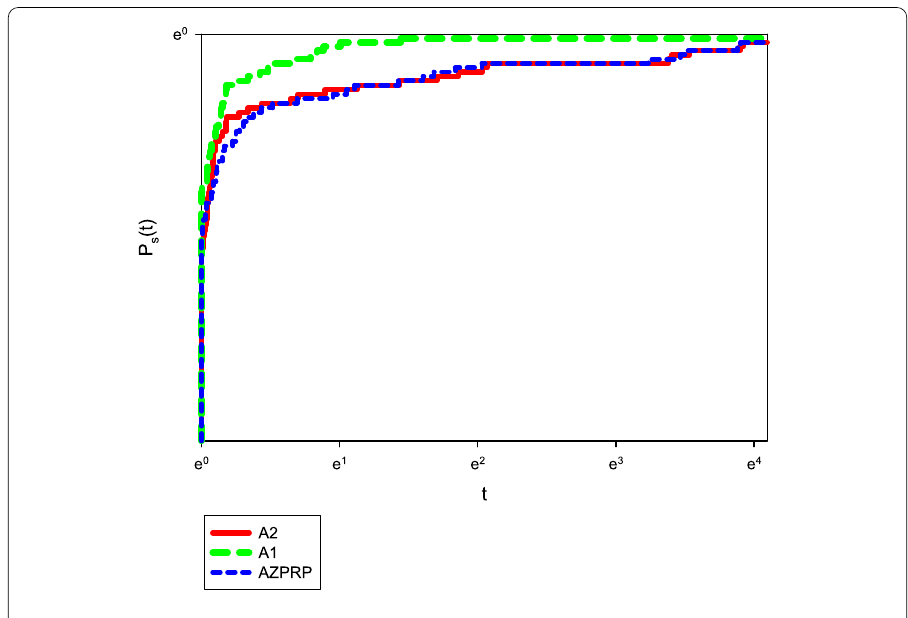
Figure 4 Performance profile based on the number of